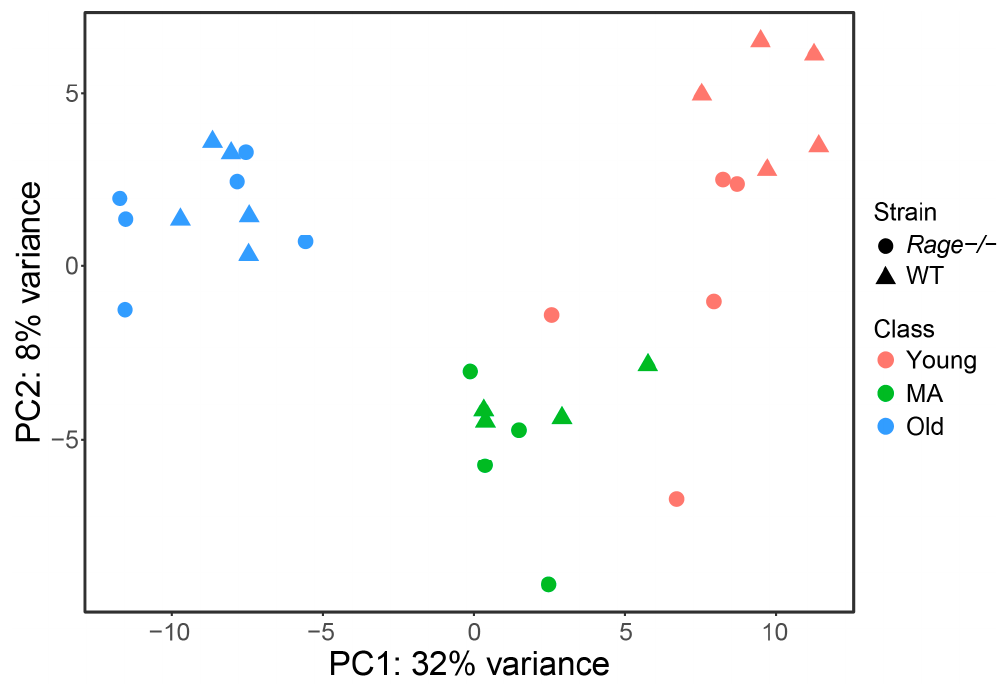
Figure 1. Unsupervised clustering of mice samples by Principal Component Analysis (PCA). A scatterplot of the first 2 principal components (PC1 and PC2) obtained from the PCA was performed using the whole gene ‐ expression dataset. Colors refer to mouse age (red = Young, green = MA, blue = Old); shape represents genotypes (triangles = WT, circles = Rage − / − ). WT = Wild Type; MA = Middle Age. Young WT n = 5, Young Rage − / − n = 5, MA WT n = 4, MA Rage − / − n = 4, Old WT n = 5, Old Rage − / − n = 6.